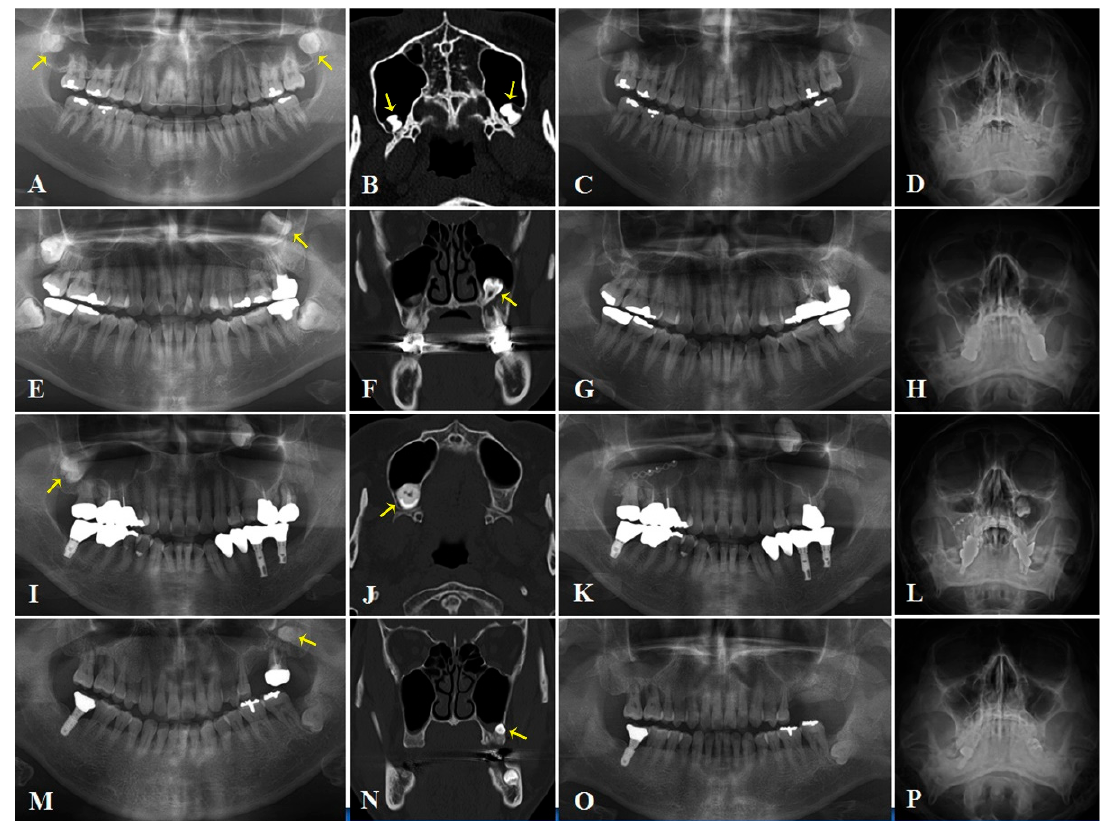
Figure 1. Preoperative panoramic view and CT showing different ectopic eruption patterns of maxillary third molars (arrow), and postoperative panoramic and Waters’ views after successful removal of the tooth via modified endoscopic- assisted sinus surgery. Case 1: Panoramic radiograph taken during the initial visit showing impacted maxillary third molars on both sides ( A ). Both maxillary third molars located in the posterior wall of the maxillary sinuses with no pathological changes, as shown in the preoperative CT ( B ). Postoperative panoramic radiograph ( C ) and Waters’ view ( D ) taken at 1 year and 6 months after successful removal of the third molars with normal transparency of the maxillary sinuses. Case 2: Preoperative panoramic radiograph showing inverted maxillary third molar in the left maxillary sinus ( E ). Preoperative CT scan showing cystic change associated with the left maxillary third molar and left maxillary sinus mucosal thickening ( F ). Postoperative panoramic radiograph ( G ) and Waters’ view ( H ) taken at 2 years and 9 months after successful removal of the left maxillary third molar with normal transparency of the maxillary sinuses. Case 3: Panoramic radiograph taken during the initial visit showing impacted right maxillary third molar ( I ). Right maxillary third molar located in the posterior-superior aspect of the right maxillary second molar, as shown in the preoperative CT ( J ). Postoperative panoramic radiograph ( K ) and Waters’ view ( L ) taken after removal of the right maxillary third molar and adaptation of the microplate. Case 4: Preoperative panoramic radiograph showing impacted left maxillary third molar ( M ). Preoperative Waters’ view showing left maxillary sinus thickening ( N ). Four months after removal of the left maxillary third molar, bone grafting was done in the left maxillary posterior alveolar ridge for future implant placement, as shown in the panoramic radiograph ( O ). Postoperative Waters’ view taken at 4 months after successful removal of the third molar with normal transparency of the left maxillary sinus ( P